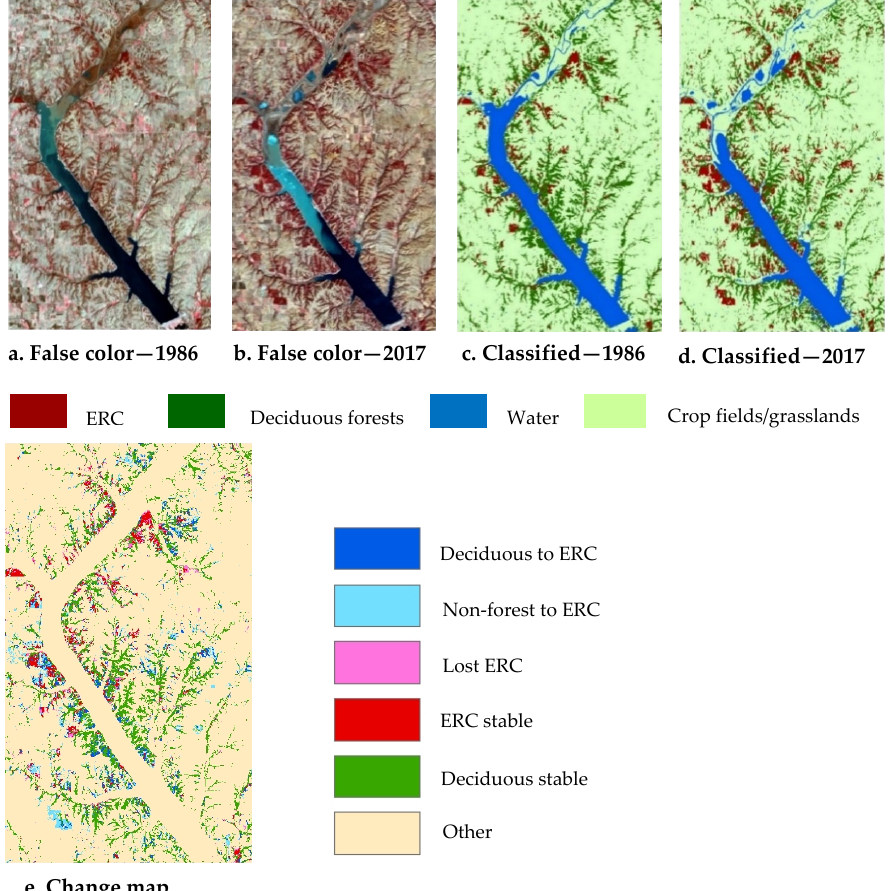
Figure 5. SA1: Tuttle Creek reservoir. ( a ) 1986 Landsat TM image, ( b ) 2017 Landsat OLI image, ( c ) 1986 classified image, ( d ) 2017 classified image, and ( e ) final change map for Study Area 1 (1986 to 2017).